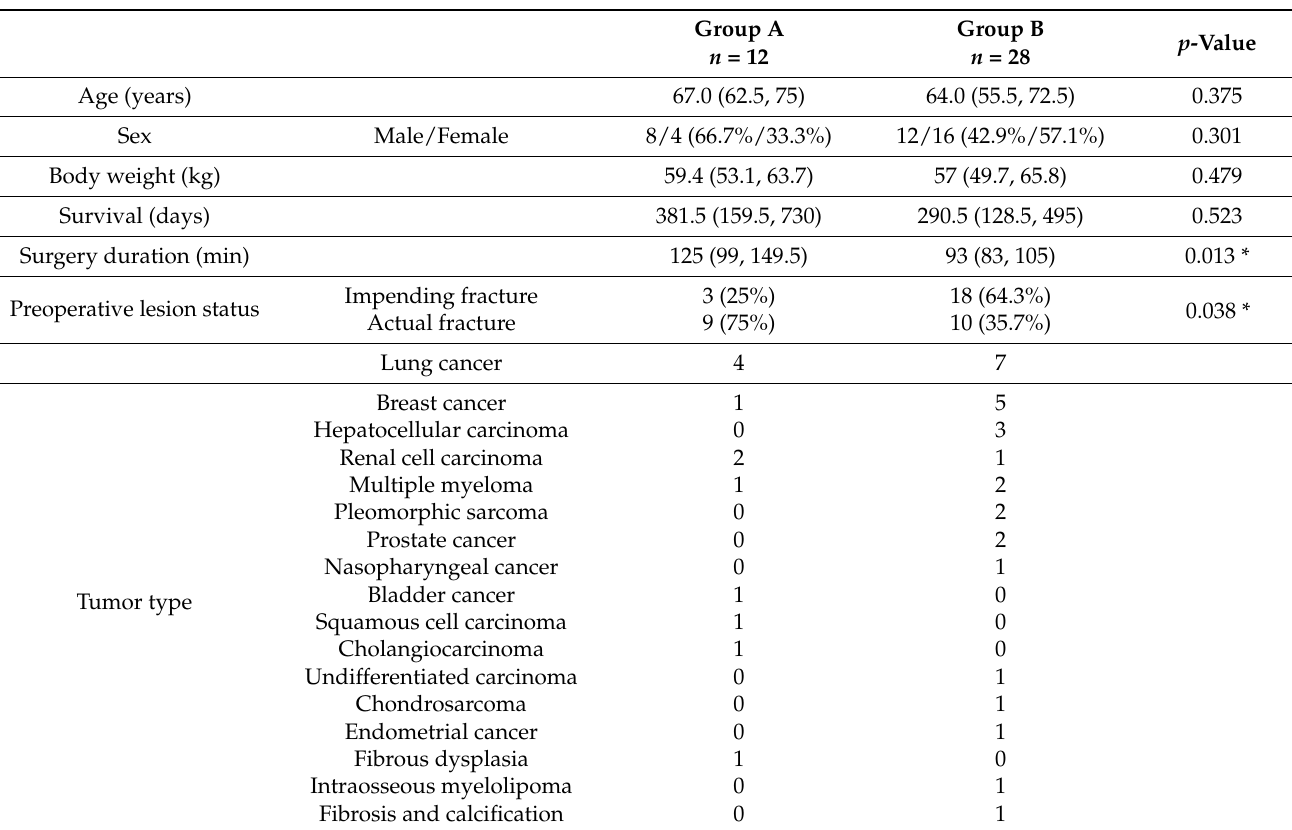
Table 1. Patient demographic data.